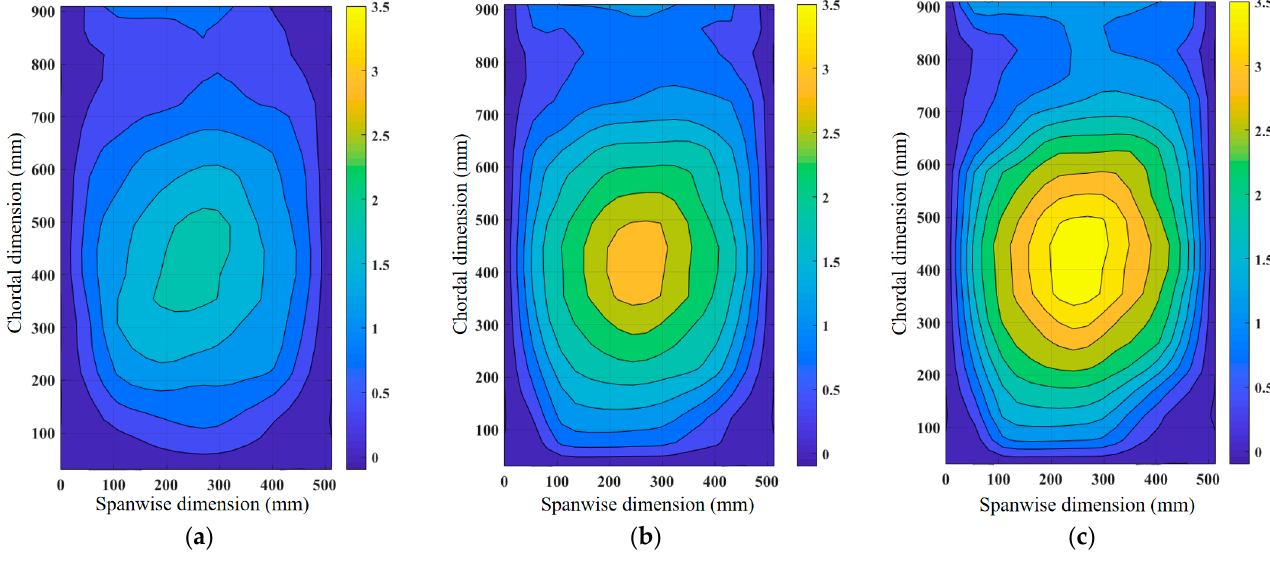
Figure 11. Deformation of the lower surface ( α = 4°): ( a ) v = 6.4 m/s; ( b ) v = 9.0 m/s; ( c ) v = 11.0 m/s.